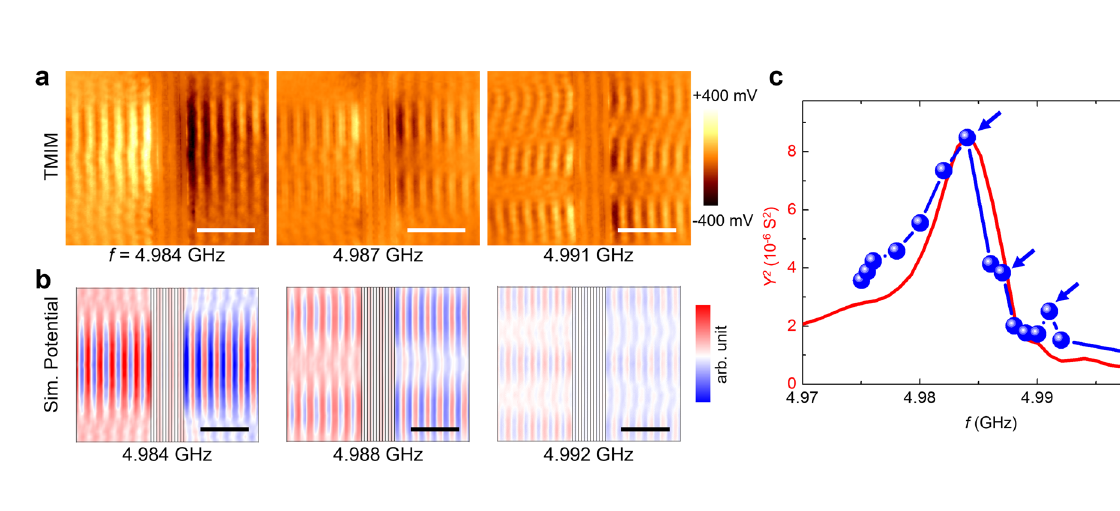
Fig. 3 | Broadband imaging ofmultiple overtones. a AFMimage atthe center of the LOBAR device, showing the IDT fi ngers. b TMIM images at fi ve selected over- tones. The corresponding frequencies are listed on the right. All scale bars are